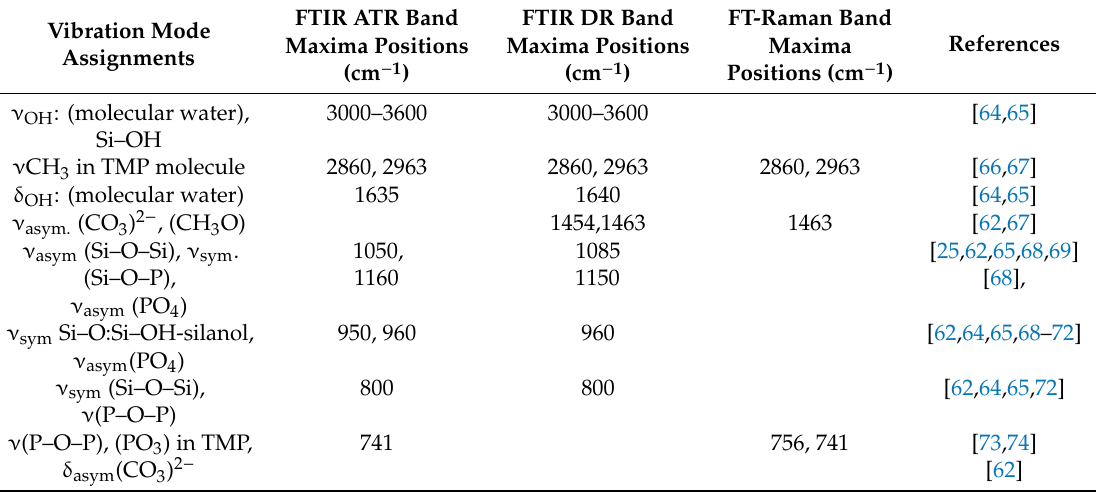
Table 2. Vibration mode assignments for FTIR and Raman